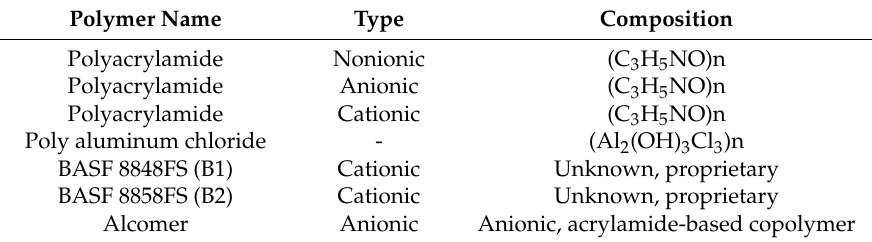
Table 2. Comparison of different